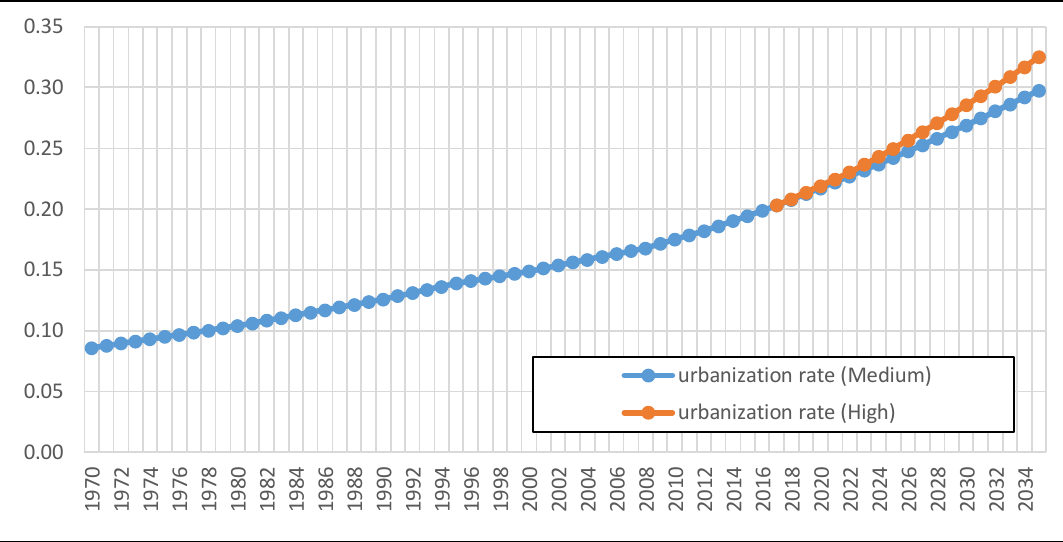
Figure 3. Scenarios for the Urbanization Rate.